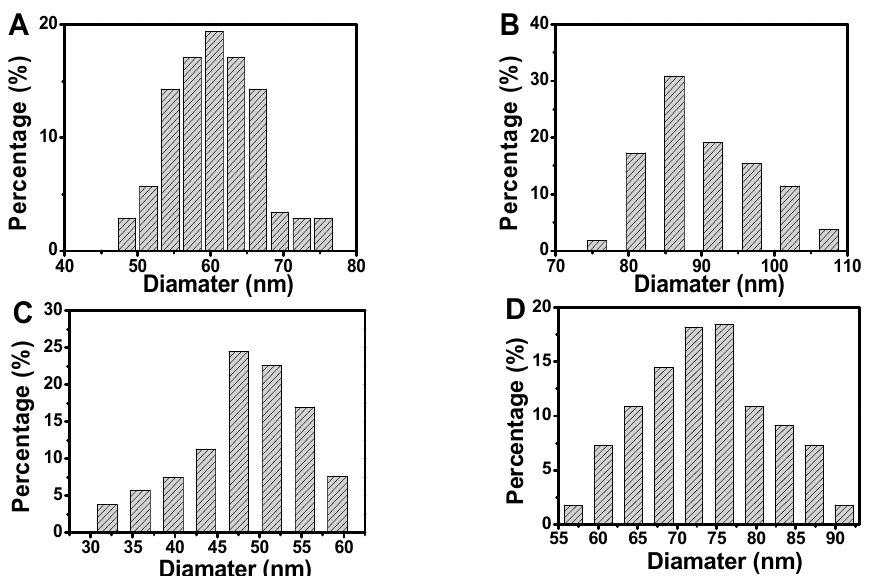
Figure 3 . Longitudinal size distribution change during the synthesis and etching of silver-coated gold nanorods. ( A ) Gold nanorods; ( B ) silver-coated gold nanorods; ( C ) etched silver-coated gold nanorods; and ( D ) the inhibited etching of silver-coated gold nanorods by AA. Conditions: Au@Ag NRs, 50 μ L; H 2 O 2 , 450 μ M; Fe 2+ ; 0.25 mM; HCl, 0.10 M; t, 25 min; T, 45 °C; and AA, 17.5 μ M.